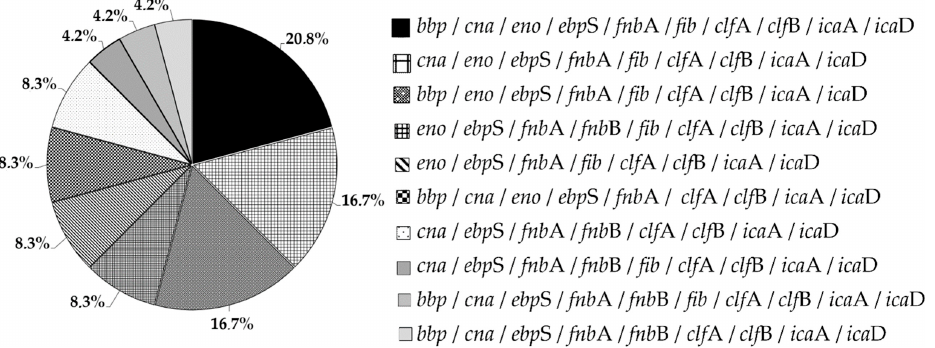
Figure 6. The frequency of occurrence of ica operon genes and genes encoding proteins from the MSCRAMM family in the studied S. aureus strains.